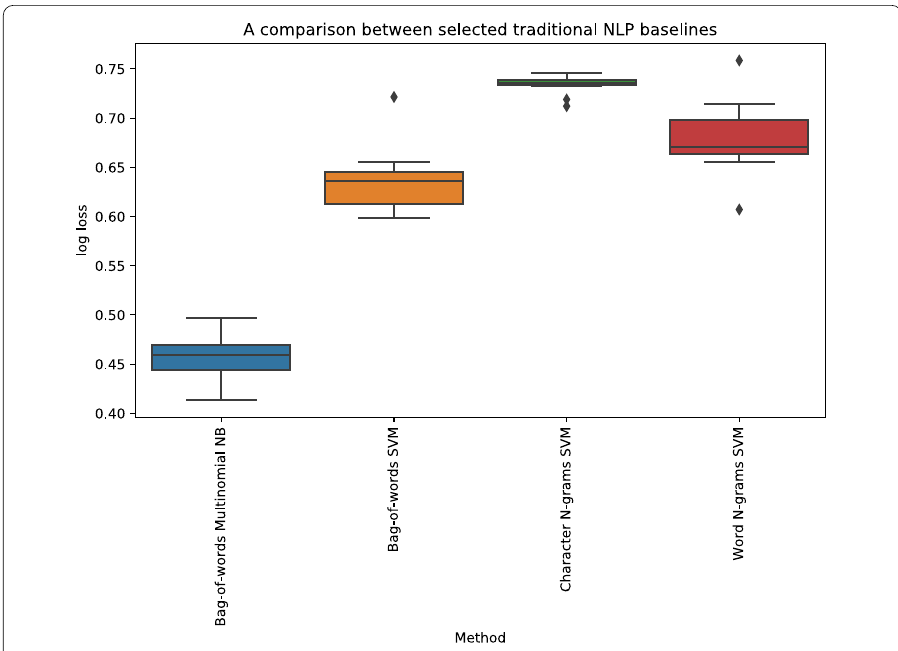
Figure 7 Comparison of performance scores from bag-of-words models (Sect. 6.1.1) and n-grams models (Sect. 6.1.2). The Multinomial NB model has been chosen as NLP